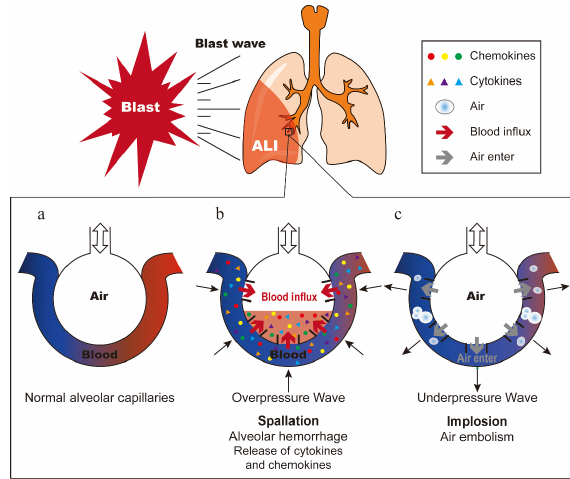
Figure 1. Damage mechanism of blast lung injury. ( a ) Normal alveolar capillaries. ( b ) Schematic diagram of spallation. Alveolar hemorrhage causes the release of cytokines and chemokines. ( c ) Schematic diagram of implosion. Air in the alveoli enters the pulmonary circulation, causing air embolism.